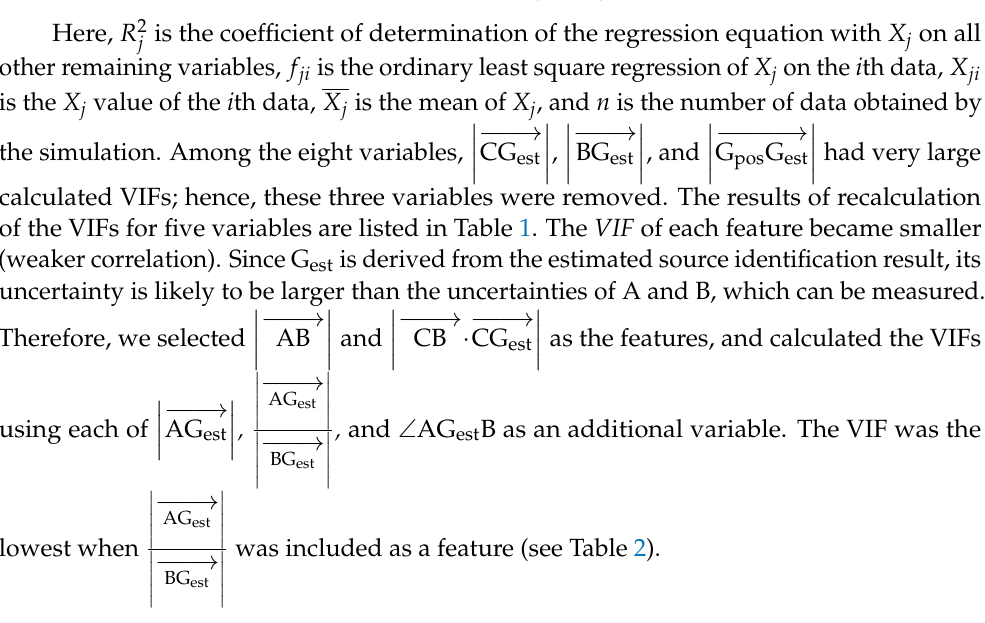
Table 1. Variance inflation factors (VIFs) for five candidate features for radiation source